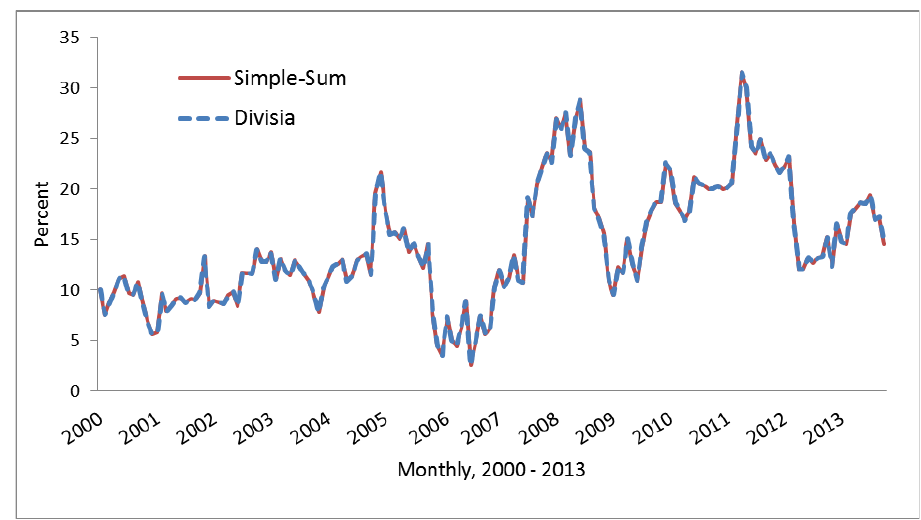
Figure 1. Year-Over-Year Growth Rates of the Divisia and Simple-Sum Monetary Aggregates, M1 (Annual Percentage Change).